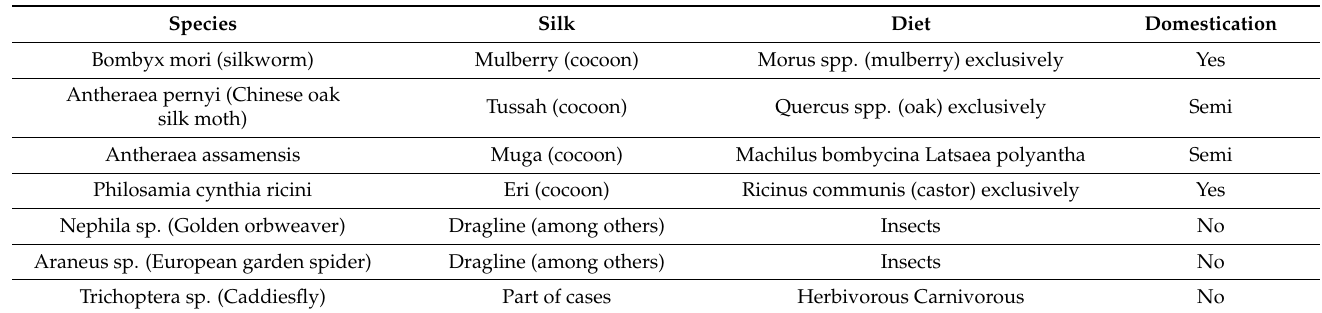
Silk-producing species, the name of their silk, and their diet and domestication grade [10,58–61].